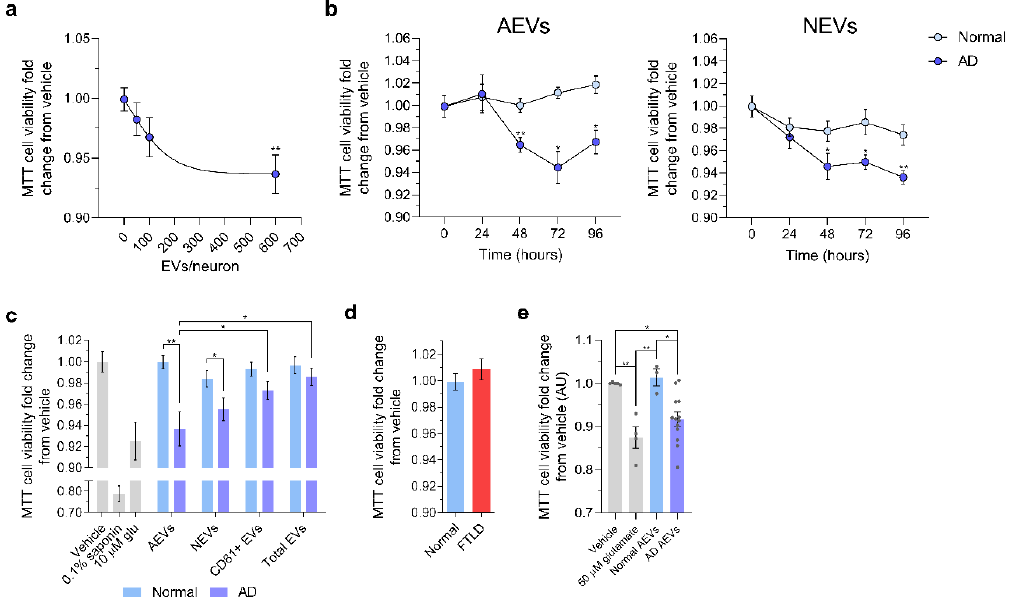
Figure 1. Alzheimer’s disease (AD) astrocytic-origin extracellular vesicles (AEVs) and neuronal-origin extracellular vesicles (NEVs) impair neuronal viability. ( a ) Scatter dot plot showing the MTT cell viability fold-change from vehicle of E18 rat cortical neurons treated with AD AEVs in a concentration-dependent manner. Each dot represents the mean value ± the standard error obtained from neurons treated with plasma-derived AEVs from 7 AD participants at the indicated concentration or vehicle (0 EVs / neuron) in triplicates. Trendline shows the four-parameter logistic nonlinear regression. ** p = 0.0015, 600 vs. 0 EVs / neuron; one-way ANOVA corrected for multiple comparisons using the Dunnet test. ( b ) Scatter dot plots with the connecting line showing the MTT cell viability fold-change from the vehicle of E18 rat cortical neurons treated in triplicates with AEVs or NEVs from 7 AD participants and 6 normal controls at 600 EVs / neuron, in a time-dependent manner. Each dot represents the mean value ± SEM. AD vs. Normal: AEVs, 48 h ** p = 0.0015, 72 h * p = 0.0191, 96 h * p = 0.0201; NEVs, 48 h * p = 0.0337, 72 h * p = 0.0127, 96 h ** p = 0.0016; two-tailed unpaired t-test with a confidence interval of 95%. Time-dependent EV treatment vs. vehicle treatment (0 h): AEVs, 48 h ** p = 0.0060, 72 h **** p < 0.0001, 96 h ** p = 0.0023; NEVs, 48 h **** p < 0.0001, 72 h * p = 0.0186; 96 h ** p = 0.0028; ordinary one-way ANOVA. ( c ) Bar graph showing a significant decrease in MTT cell viability (fold-change from vehicle) in E18 rat cortical neurons treated with AEVs and NEVs, but not CD81 + EVs and total plasma EVs from 7 AD participants, compared to neurons treated with AEVs and NEVs from 6 normal controls, respectively. Neurons treated with 0.1% saponin detergent and 10 µ M glutamate were used as positive controls for neurotoxicity. Each bar represents the mean value ± SEM from triplicate wells and five di ff erent experiments; the condition of 600 EVs / neuron and incubation for 48 h was selected based on ( a , b ). Analysis was based on mixed linear model accounting for technical (well, experiment) and biological (Subject, Group) variability and including all EV types. For NEVs, AD vs. Normal, p = 0.003. For AEVs, AD vs. Normal, p = 0.006. For CD81 + EVs, AD vs. Normal, p = 0.904. For total EVs, AD vs. Normal, p = 0.675. For AD participants, NEVs and AEVs had similar e ff ects on MTT (AEVs vs. NEVs, p = 0.695), but AEVs decreased MTT compared to both CD81 + ( p = 0.035) and total EVs ( p = 0.029), and NEVs showed similar strong trends in pairwise comparisons ( p = 0.087 and p = 0.067 respectively). * p < 0.05, ** p < 0.01. ( d ) Bar graph showing the MTT cell viability fold-change from the vehicle of neurons treated with AEVs from two FTLD and 6 normal control participants. No di ff erence in cell viability was observed ( p = 0.934). Treatments were carried out as indicated in ( c ). Bar graph showing a significant decrease in MTT cell viability in E18 rat cortical neurons treated with AEVs from 13 autopsy-confirmed AD patients and 3 neurologically normal controls from JH ADC, all part of an independent cohort di ff erent from that used for ( a – e ). Each bar represents the mean value ± SEM from five wells and two independent experiments. Vehicle vs. 50 µ M glutamate, ** p = 0.0038; Vehicle vs. AD AEVs, * p = 0.0225; 50 µ M glutamate vs. Normal AEVs, ** p = 0.0048; Normal AEVs vs. AD AEVs, * p =